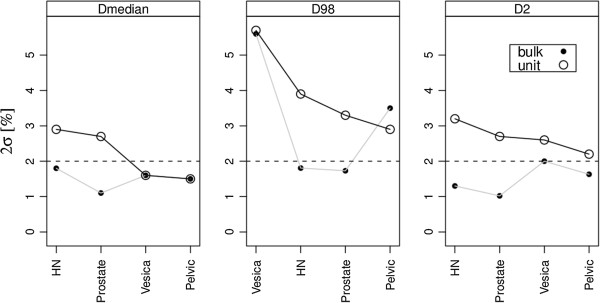
The approximate 95% CI for the dosimetric differences of the PTV when comparing CT and density corrected MRI. Deviations are plotted in a descending order for the MRIu data. MRIu = unit. MRIb = bulk.